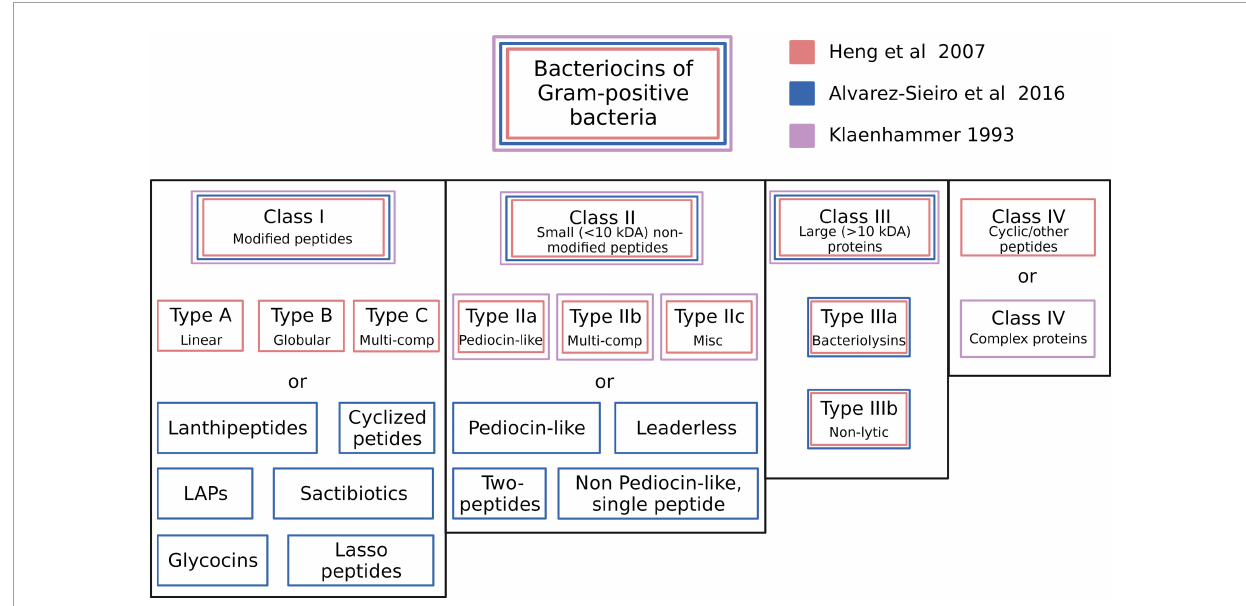
FIGURE2 Schematic illustration of the bacteriocin typing schemes proposed by Klaenhammer (1993), Heng et al. (2007c), and Alvarez-Sieiro et al. (2016). The proposed classes for each scheme are color coded. Created with